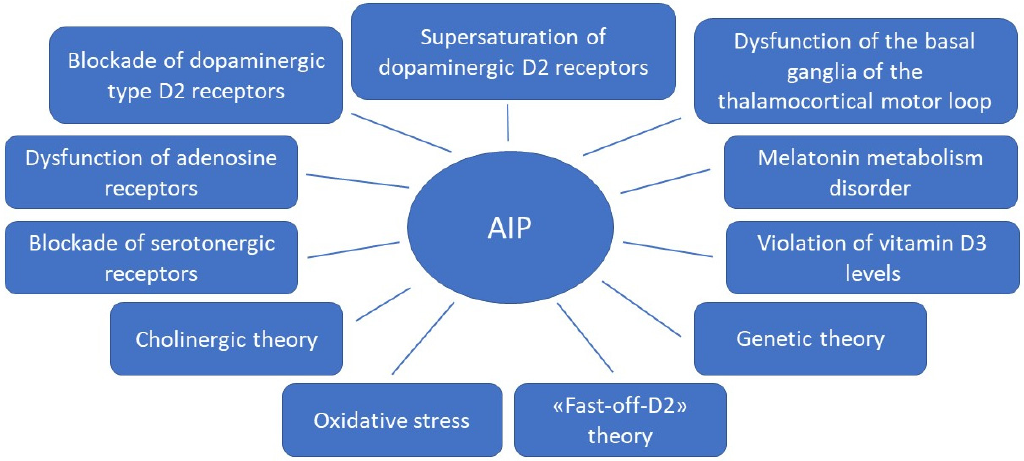
Figure 1. Theories for the development of antipsychotic-induced parkinsonism. One of the causes of AIP is a disruption of neurotransmitter interactions that regulate the signaling pathways of the dopaminergic, cholinergic, GABA-ergic, adenosinergic, endo- cannabinoid and other neurotransmitter systems. The monoamine (dopamine, serotonin, and norepinephrine) systems of the brain play an important role in normal behavior, and disturbances in these circuits are thought to be involved in the development of a number of neurological and psychiatric disorders. The dopamine system is involved in the